Question: Express in one sentence what the figure is showing.
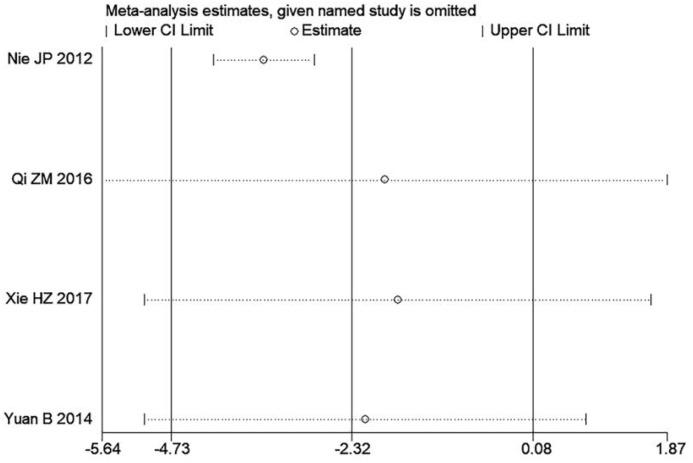
Answer: Results of the ESR sensitivity analysis in the CHM vs. WM group.